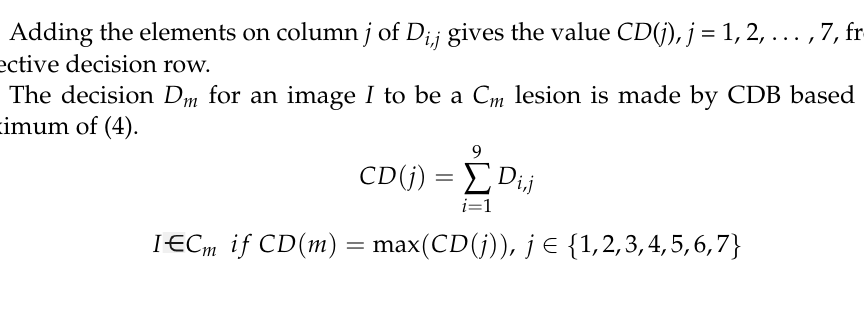
Figure 6. Decision matrix [ D ] and collective decision ( CD ).